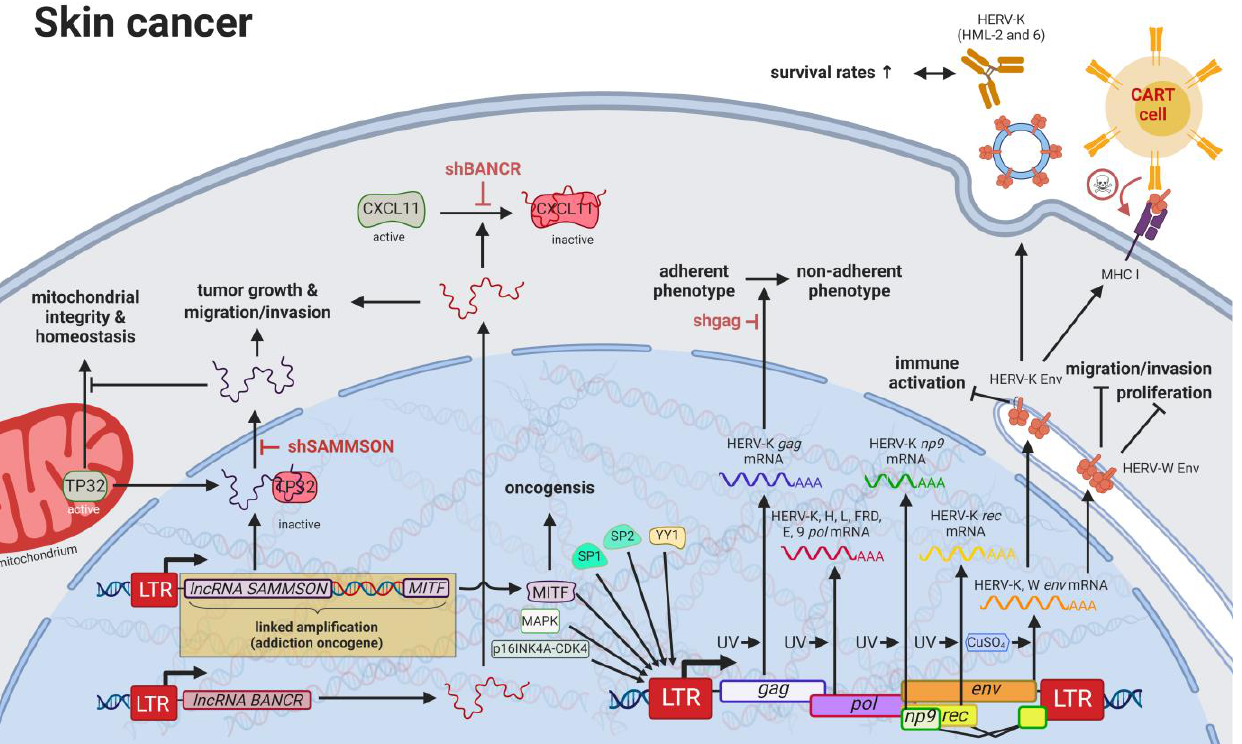
Figure 4. The role of HERVs in skin cancer. Evaluated treatments are marked in red. Abbreviations: LTR = long terminal repeat, gag = group antigen (capsid), pol = polymerase, RT = reverse transcriptase, env = envelope, lncRNA = long non-coding RNA, shBANCR = siRNA targeting BANCR. If not otherwise stated HERV-K = HML-2.